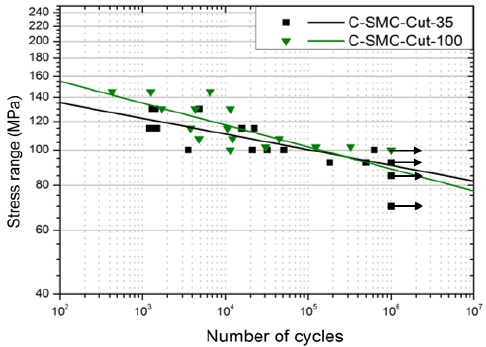
Figure 13. S–N curves for the fatigue test result comparison between C-SMC-Cut-100 and C-SMC- Cut-100.